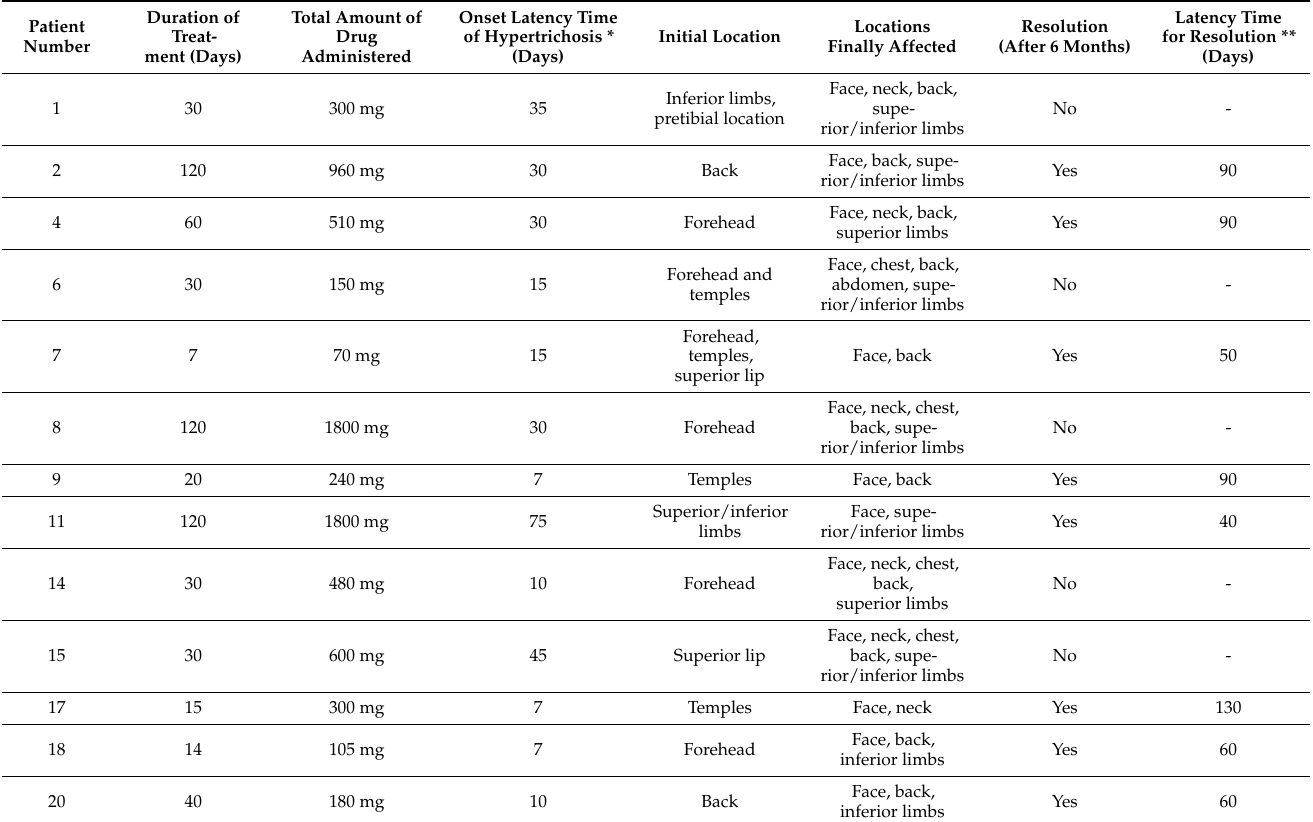
Table A2. Characteristics of the patients who developed